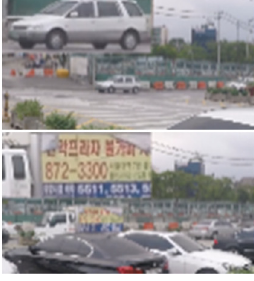
Figure 6. Ablation experiment of multiscale iterative strategy. ( a ) ground truths; ( b ) blurred images; ( c ) deblurring results of single-scale; ( d ) deblurring results of multi-scale.